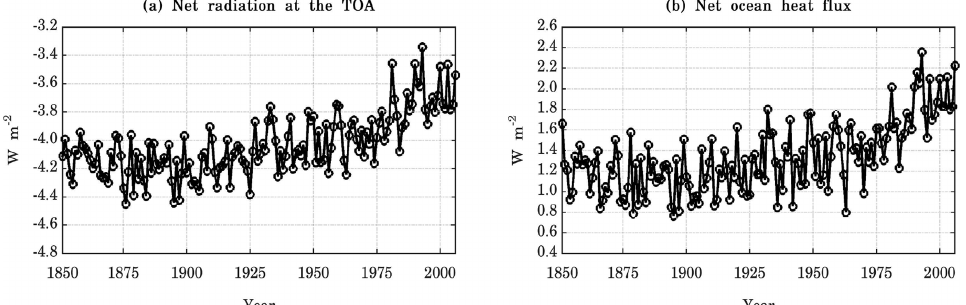
Figure 3. Annual average time series for the global average (a) net radiation at the TOA (positive values indicate that the atmosphere is warming) and (b) net ocean/atmosphere heat flux (positive values indicate that the ocean is warming), as simulated by the historical run over the period 1850–2005 (156 years). Units are in watts per square